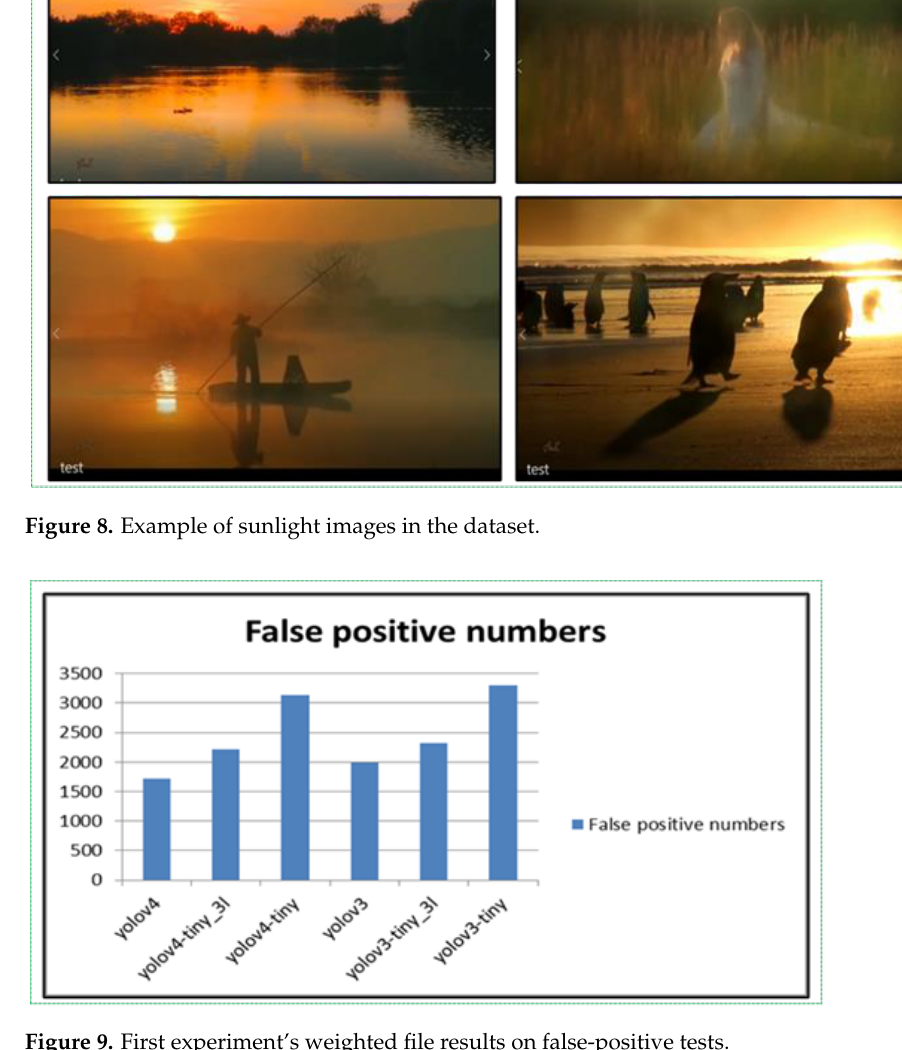
Figure 8. Example of sunlight images in the dataset.